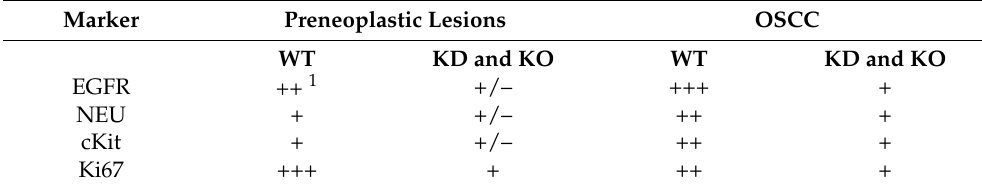
isolated from wild type (WT), PI3K γ KD/KD (KD) and PI3K γ − / − (KO) mice. Marker Preneoplastic Lesions OSCC WT KD and KO WT KD and KO EGFR ++ 1 +/– +++ + NEU + +/– ++ + cKit + +/– ++ +